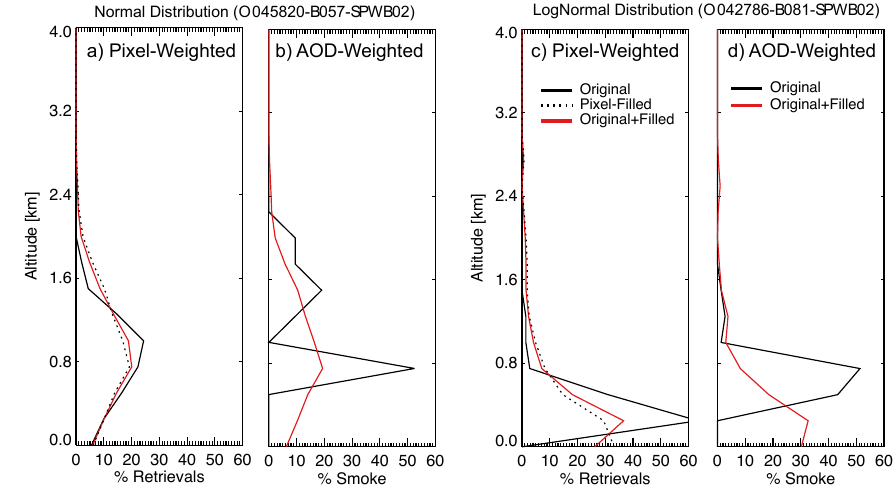
Figure 5. Examples of stereo-height retrieval vertical distributions for smoke plumes with normal (O045820-B057-SPWB02, shown in Figure 3 bottom row; panels ( a , b ) here) and lognormal (O042786-B081-SPWB02; panels ( c , d ) here) distribution fits. ( a , c ) Distributions weighted by pixel counts. Solid black lines indicate original successful retrievals, dashed black lines represent missing retrievals that were filled as described in Section 2.2, and red lines are the sum of original and filled retrievals. ( b , d ) Distributions weighted by AOD. Solid black lines indicate original retrievals with AOD values, and red lines are the sum of original AOD and filled retrievals, in which missing AOD values were filled by the maximum AOD in each